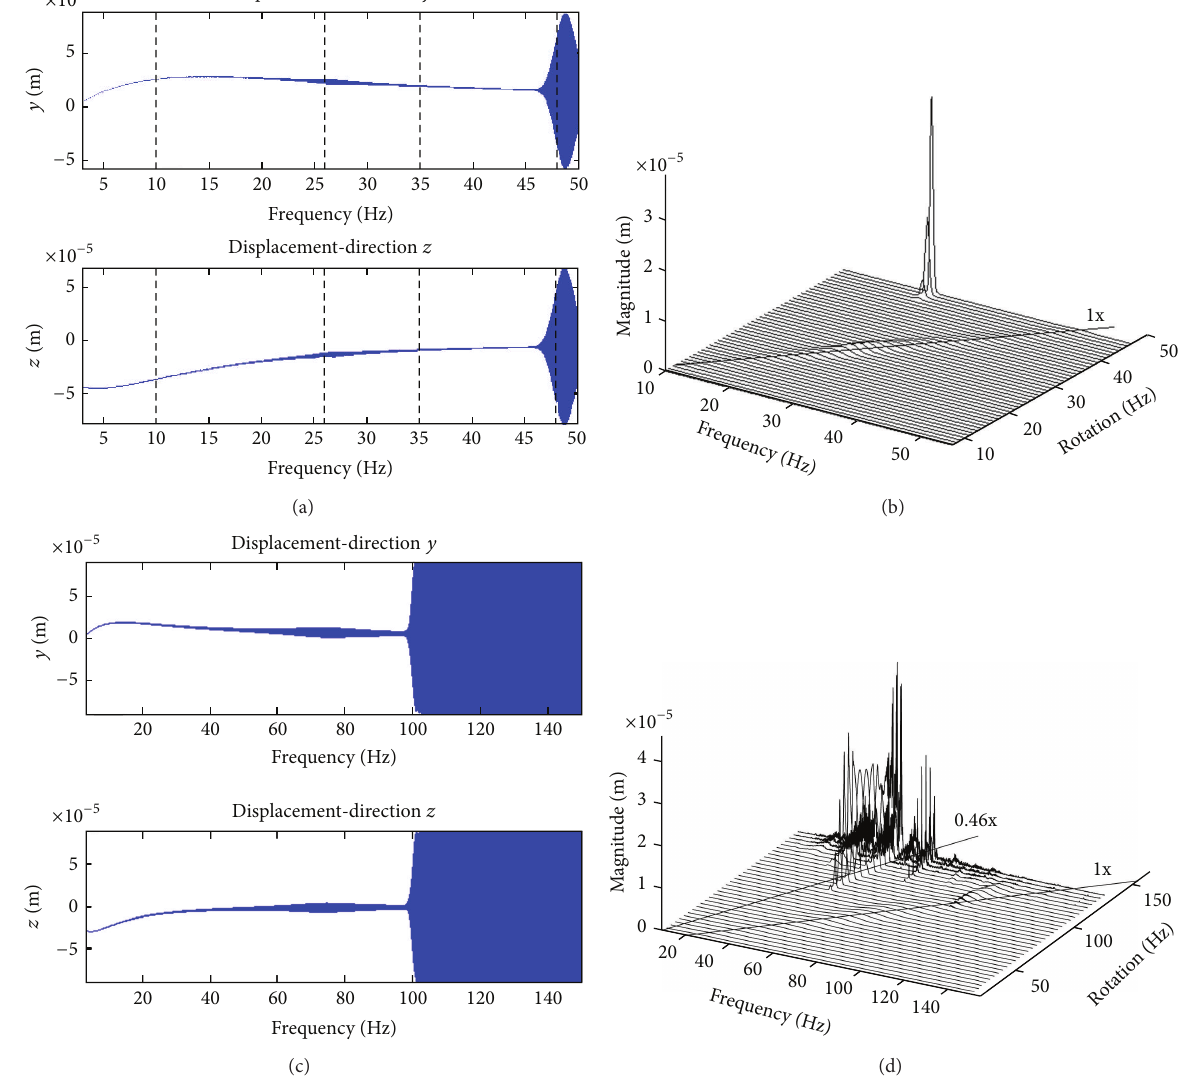
Figure 9: Run-down simulations: (a) time response of the first bearing in configuration A (see Figure 1); (b) waterfall diagram of the first bearing in configuration A; (c) time response of the first bearing in configuration B; (d) waterfall diagram of the first bearing in